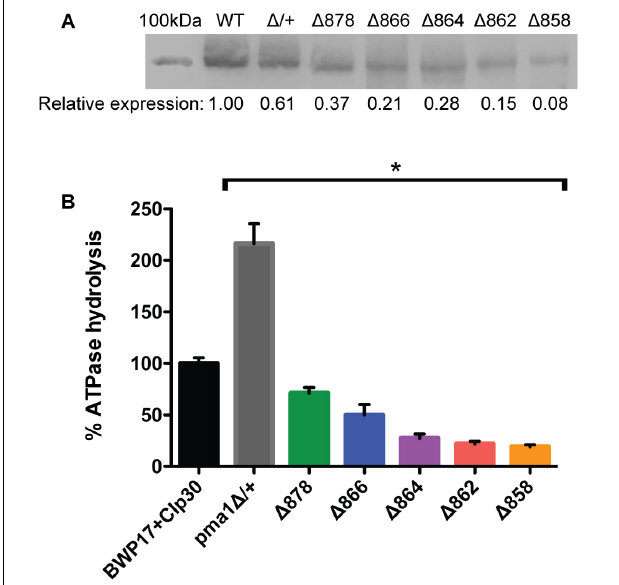
FIGURE 1 | Pma1p truncation mutants have decreased plasma membrane Pma1p levels and decreased plasma membrane ATPase activity. Plasma membranes were isolated from exponentially growing cells via zymolyase- and glass bead-mediated cell wall disruption followed by density-gradient sucrose centrifugation. Plasma membranes were isolated independently in quadruplicate. (A) Western blot using a rabbit primary antibody raised against the N-terminus of S. cerevisiae Pma1p and a goat anti-rabbit secondary antibody conjugated to an IR dye with fluorescence at 800 nm. 100 kDa indicates a 100 kDa marker band (Precision Plus Protein ladder, Bio-Rad) stained with Coomassie blue and captured via measuring fluorescence at 700 nm. The expected size of C. albicans Pma1p is approximately 100 kDa. WT indicates the wild-type control strain, BWP17+CIp30. Western blots were performed independently in triplicate. Relative expression levels were quantified using Licor ImageStudio software and normalized to expression in the wild-type control strain. Pma1p levels decrease with increasing Pma1p truncation in isolated plasma membranes. Pma1p levels are also decreased in a strain heterozygous for PMA1 . (B) Percent ATPase-specific activity in isolated plasma membranes as compared to ATPase-specific activity in the BWP17+CIp30 wild-type control. ATPase hydrolysis activity was measured using an enzymatic assay in which the rate of ATP hydrolysis is coupled to the oxidation of NADH, measured as a loss of A 340 over time. ATPase assays were performed four times independently, with four technical replicates